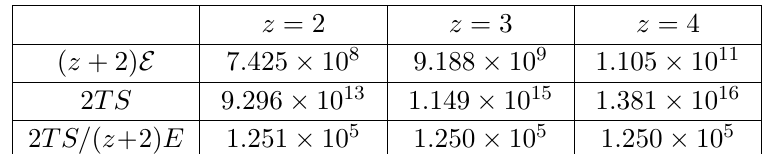
Table 2 . The numerical values of ( z + 2) E and 2 TS for z = 2 , 3 , 4 . The final row of the table contains the ratio 2 TS/ ( z + 2) E . Here we did not divide the first two rows with f will be the